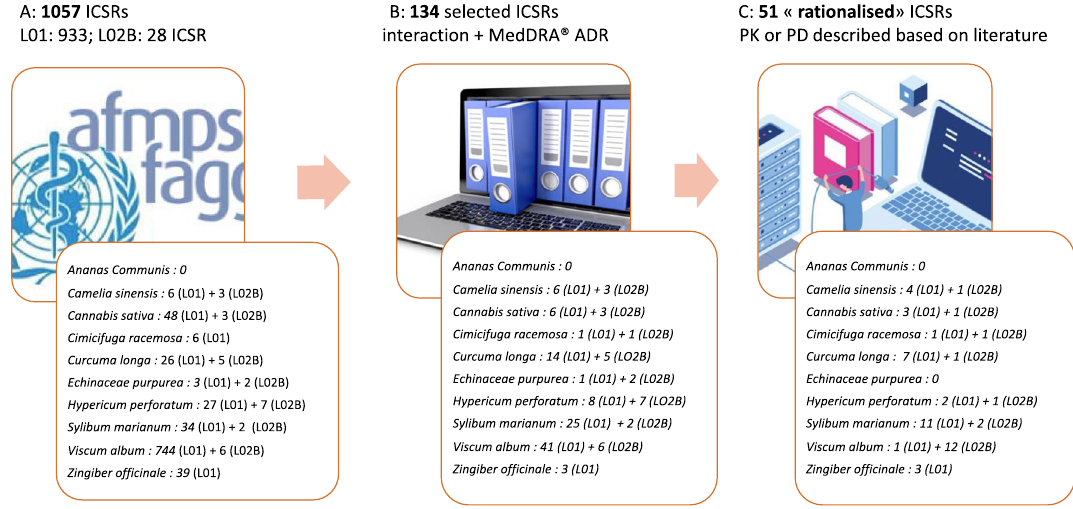
Figure 1. Flow chart from the selection of the 1057 ICSRs from VigiBase ( A ). In the first step,1057 ICSR have been selected with 933 ICRS implicated drugs in L01 ATC class and 28 L02Bdrugs. At ( B ) step only 134 ICSR were selected for further investigation because they include atleast “suspected” or “interacting” drugs/herb interaction and at least one adverse reaction. Thelast step ( C ) consists in the rationalization of the possible ADR due to PK or PD describedinteractions in